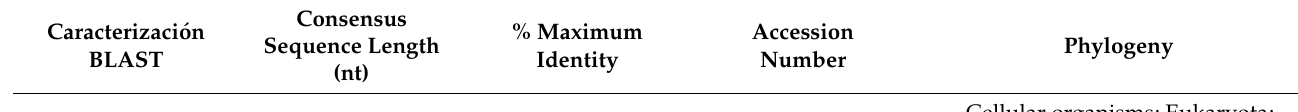
Table 2. BLAST characterization of the yeast rDNA sequence isolated from the MFC anode plate with onion substrate.